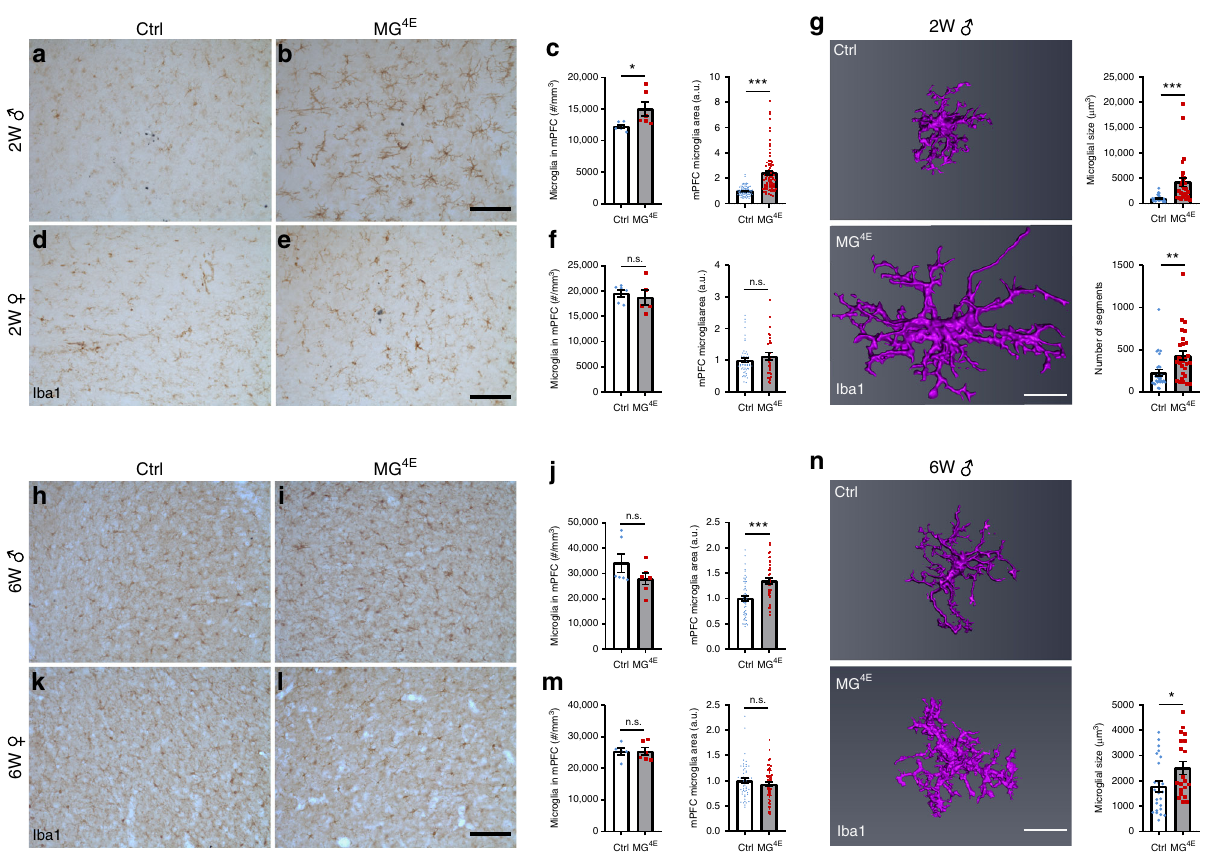
Fig. 3 Iba1 immunohistochemistry reveals altered microglial density and morphology in male MG 4E mice. a – c Increased microglial density and size in the mPFC of male MG 4E mice. n = 7 control mice and 6 MG 4E mice. Ten microglia from each mouse were randomly selected for measurement of cell size (cross section area). * p = 0.0342 and *** p < 0.001 by two-sided t -test. Scale bar, 100 μ m. d – f Comparable microglial density and size in the mPFC between female control and MG 4E mice. n = 6 control mice and 5 MG 4E mice. Five to ten microglia from each mouse were randomly selected for measurement of cell size (cross section area). n.s. not signi fi cant by two-sided t -test. Scale bar, 100 μ m. g Three-dimension reconstruction of microglia in the mPFC of 2- week-old male mice. n = 7 mice per group. Three to fi ve microglia from each mouse were reconstructed for determination of cell size (volume) and number of processes. ** p = 0.0037 and *** p = 0.0005 by two-sided t -test. Scale bar, 20 μ m. h – m Microglia density and size in the mPFC of 6-week-old male ( h – j ) and female ( k – m ) MG 4E mice. Ten microglia in each brain region of each mouse were randomly selected for measurement of cell size (cross section area). Male, n = 6 mice per genotype; female, n = 5 control mice and 6 MG 4E mice. Two-sided t -test: *** p < 0.001 and n.s. not signi fi cant. Scale bar, 100 µ m. n Three-dimension reconstruction of microglia in the mPFC of 6-week-old male mice. Four microglia from each mouse were reconstructed. Six control mice and fi ve MG 4E mice. * p = 0.0385 by two-sided t -test. Scale bar, 20 µ m. All data are shown as mean ± s.e.m. Source data are provided as a Source Data fi